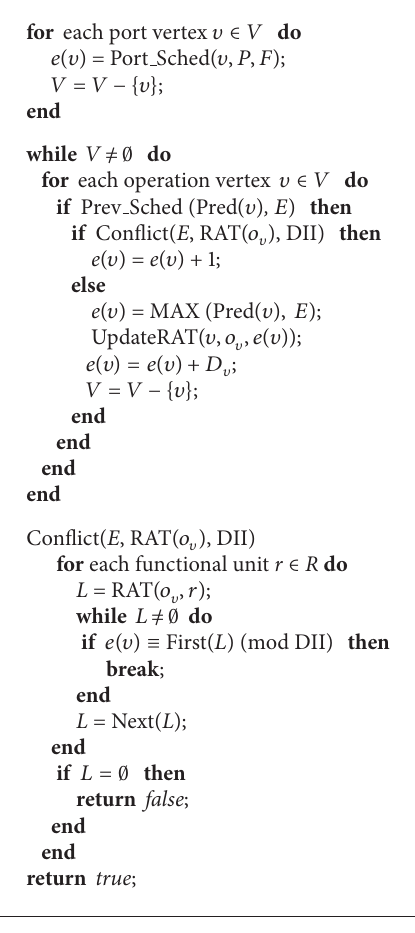
Algorithm 1: Heuristic minimum-resource